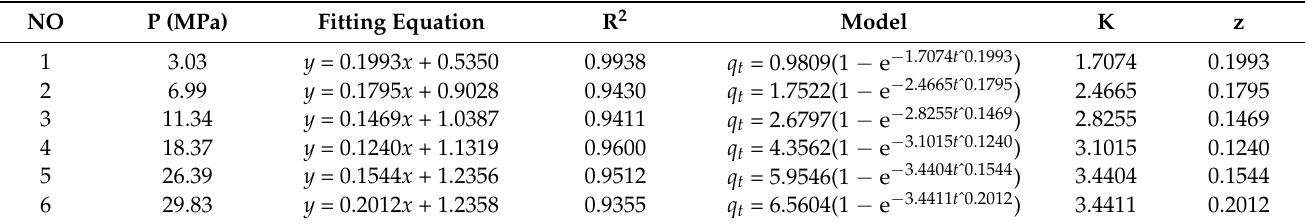
Table 2. The results of fitting methane adsorption dynamic using Bangham model at 40 ◦